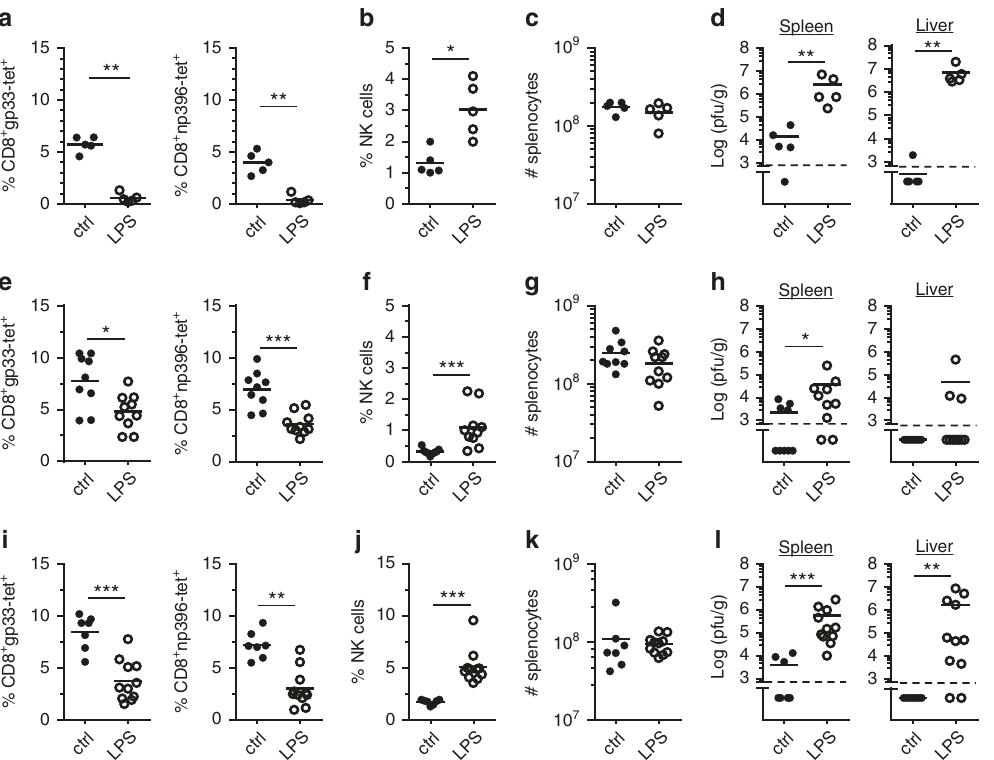
Fig. 6 De fi ciency in NCR1 or NKG2D does not prevent LPS-induced negative T cell regulation. NKG2D-de fi cient ( a – d , n = 5), NKp46 icre/icre ( e – h , n = 9 – 10) and B6.CD45.1- Ncr C14R mice ( i – l , n = 8 – 11) were infected with LCMV. One day later, they received LPS or PBS (ctrl). Mice were analyzed at day 8 after LCMV infection. a , e , i gp33- and np396-tetramer + (tet) CD8 T cells in percent of spleen cells. b , f , j Percent NK cells (CD3 – NK1.1 + ) of spleen cells. c , g , k Absolute numbers (#) of spleen cells. d , h , l Viral titers in spleen and liver. Data of individual mice from 2 to 3 independent experiments with 2 – 6 mice per group are shown; horizontal bars represent the mean values. Dashed lines indicate detection limits. * p < 0.05, ** p < 0.01, *** p <